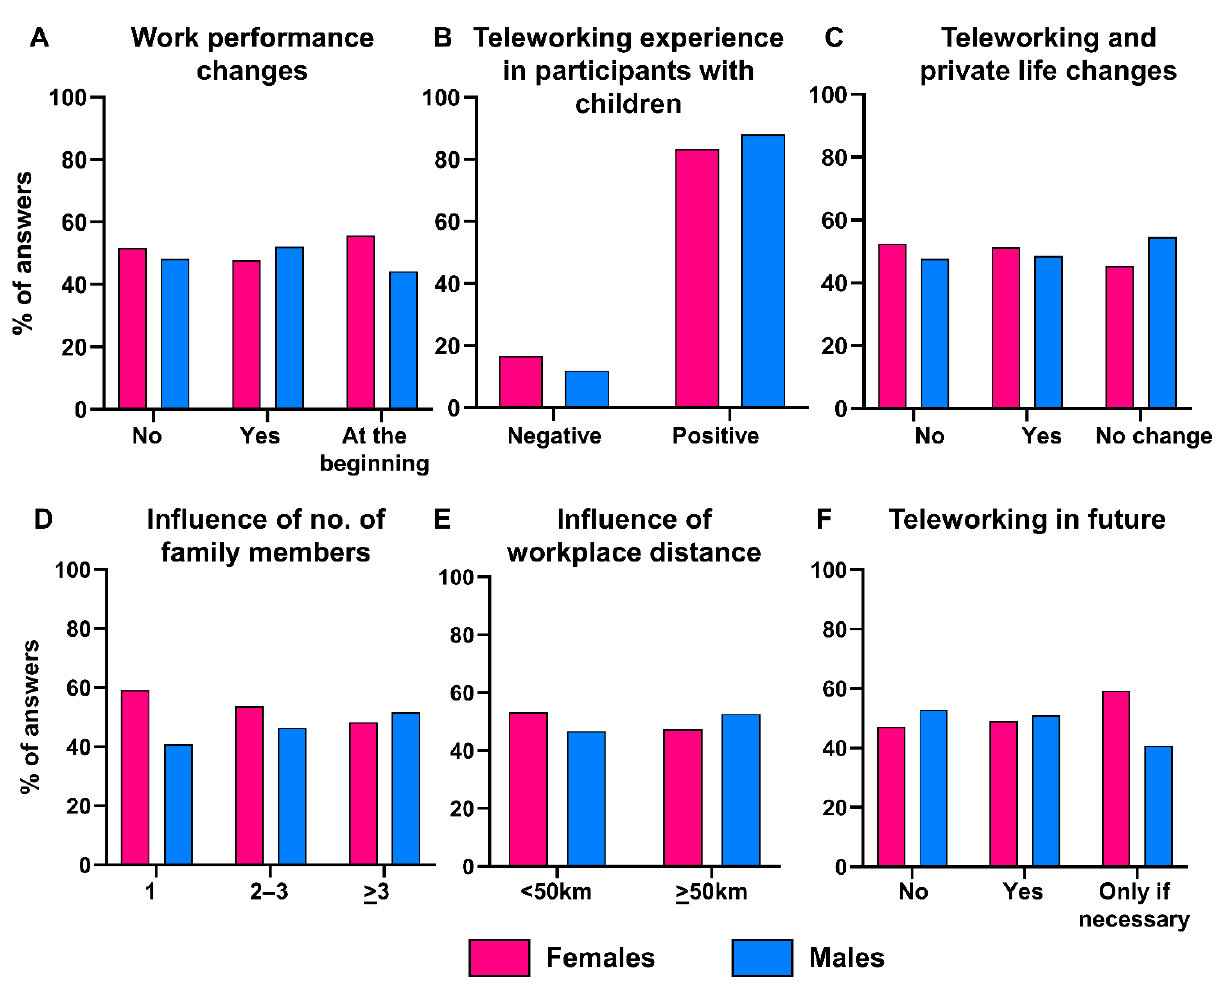
Figure 1. Gender differences and teleworking during COVID-19 pandemic. ( A ) Differences in work performance were stratified by gender and reported as bar graphs. ( B ) Teleworking experience in females with children, and ( C ) influence in private life stratified by gender. Among participants with a positive experience with teleworking, the impact of the number of family members ( D ) and home-to-workplace distance ( E ) was investigated after stratification by gender. ( F ) Percent of answers about willingness to continuing teleworking even after pandemic, stratified by gender.